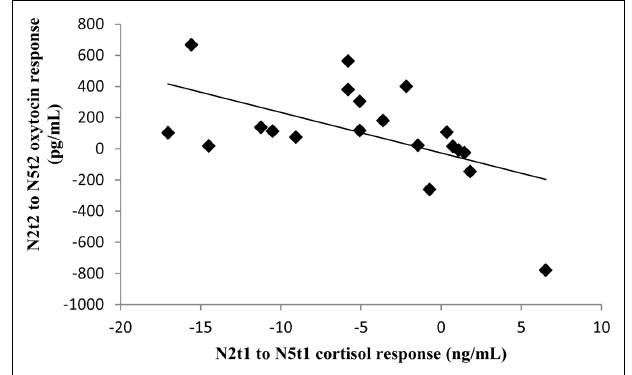
FIGURE 4 | Scatterplot of the relationship between the N5t2–N2t2 oxytocin response and the decrease in cortisol from N2t1 to